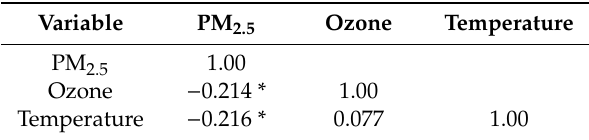
Table A1. Pearson correlation coe ffi cients among daily concentrations of air pollutants and daily average temperature.